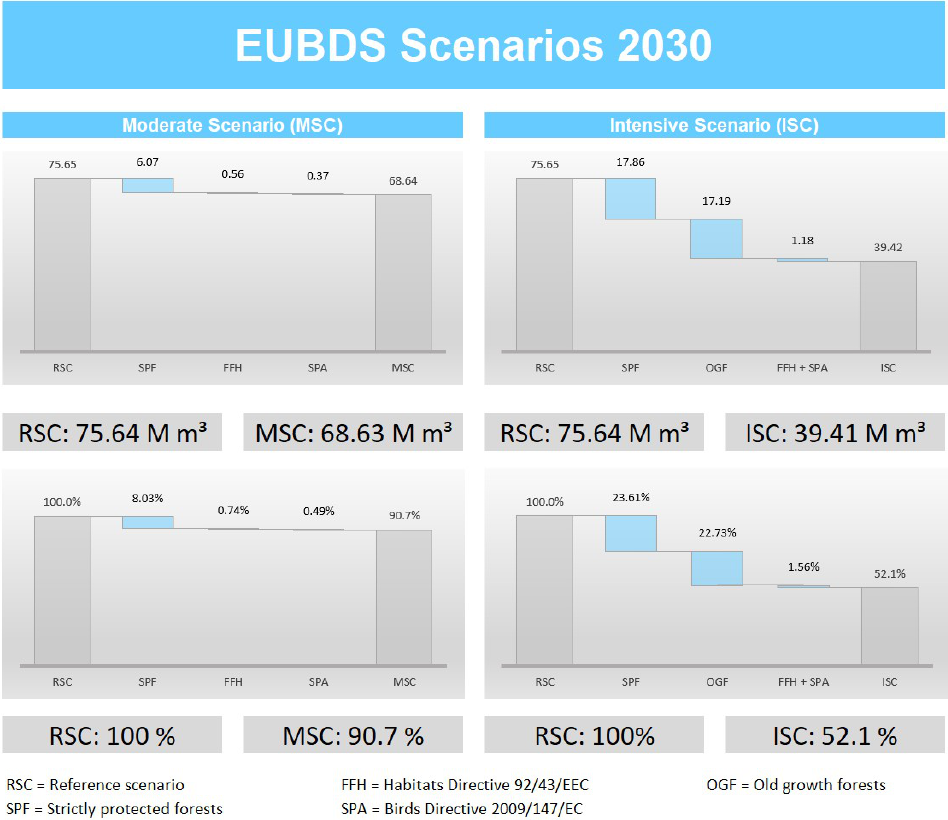
Figure 1. Absolute and relative changes in potential roundwood production in the moderate (MSC) and intensive scenario (ISC) compared to the WEHAM scenario [27] on potential roundwood for the period from 2028–2032 and onwards [authors’ results].